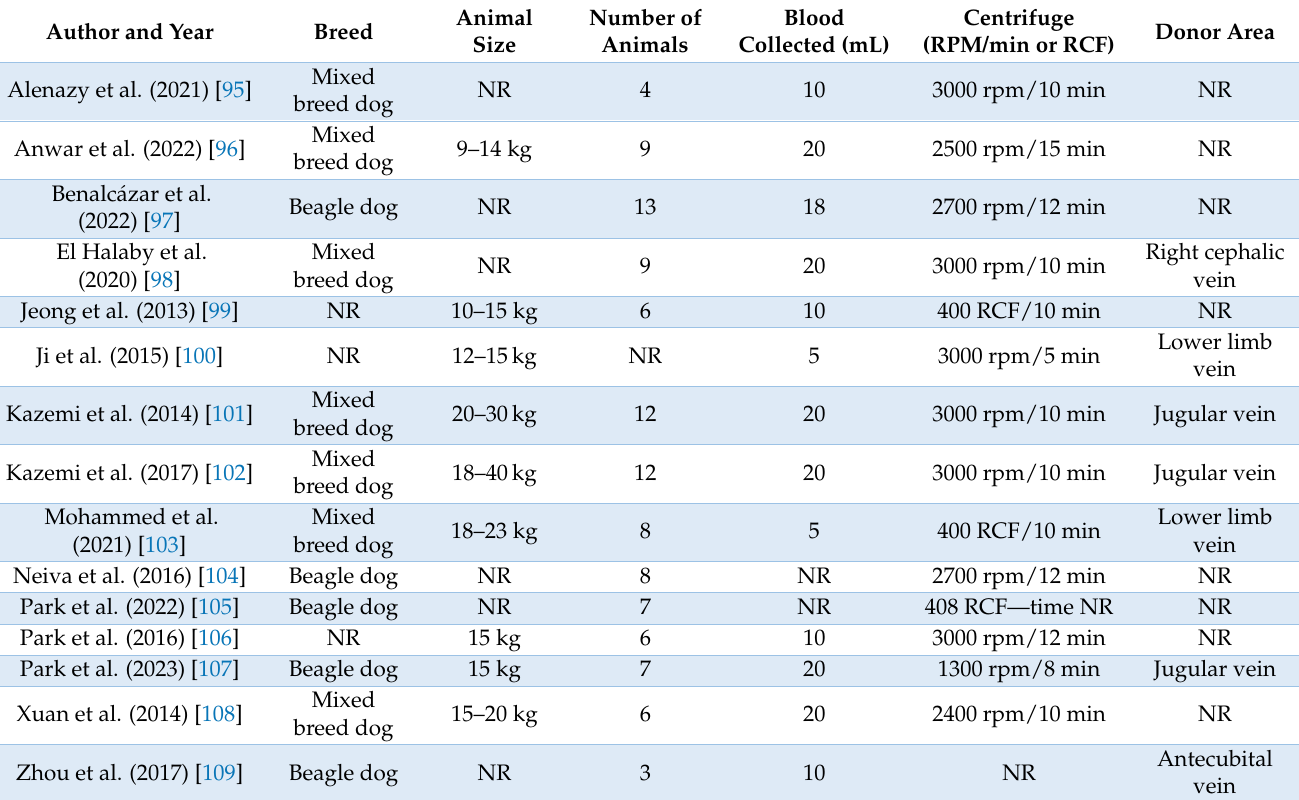
Table 3. Data was collected from the PRF process using the dog